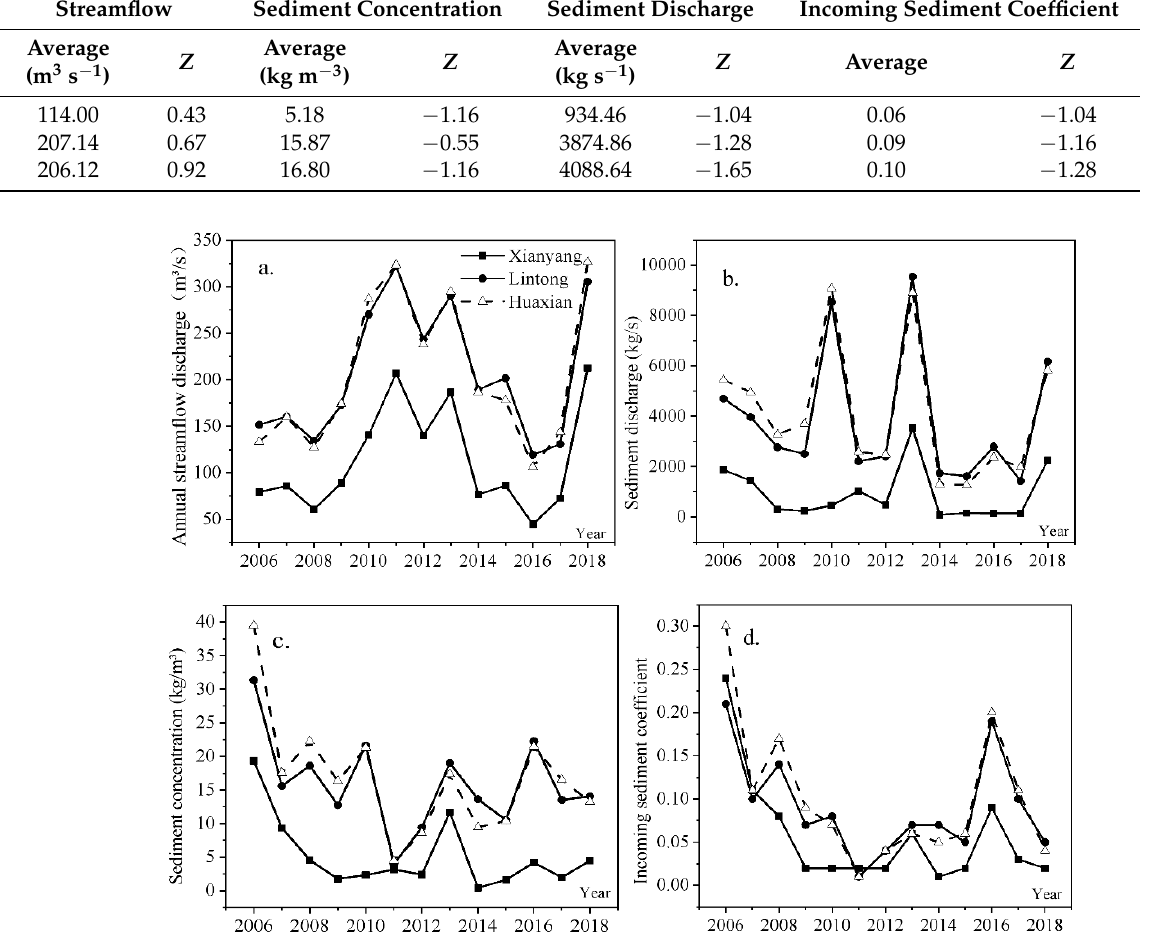
Figure 9. Variation of: ( a ) streamflow discharge; ( b ) sediment discharge; ( c ) sediment concentration; and ( d ) incoming sediment coefficient in the lower Weihe River during flood season in 2006 – 2018.